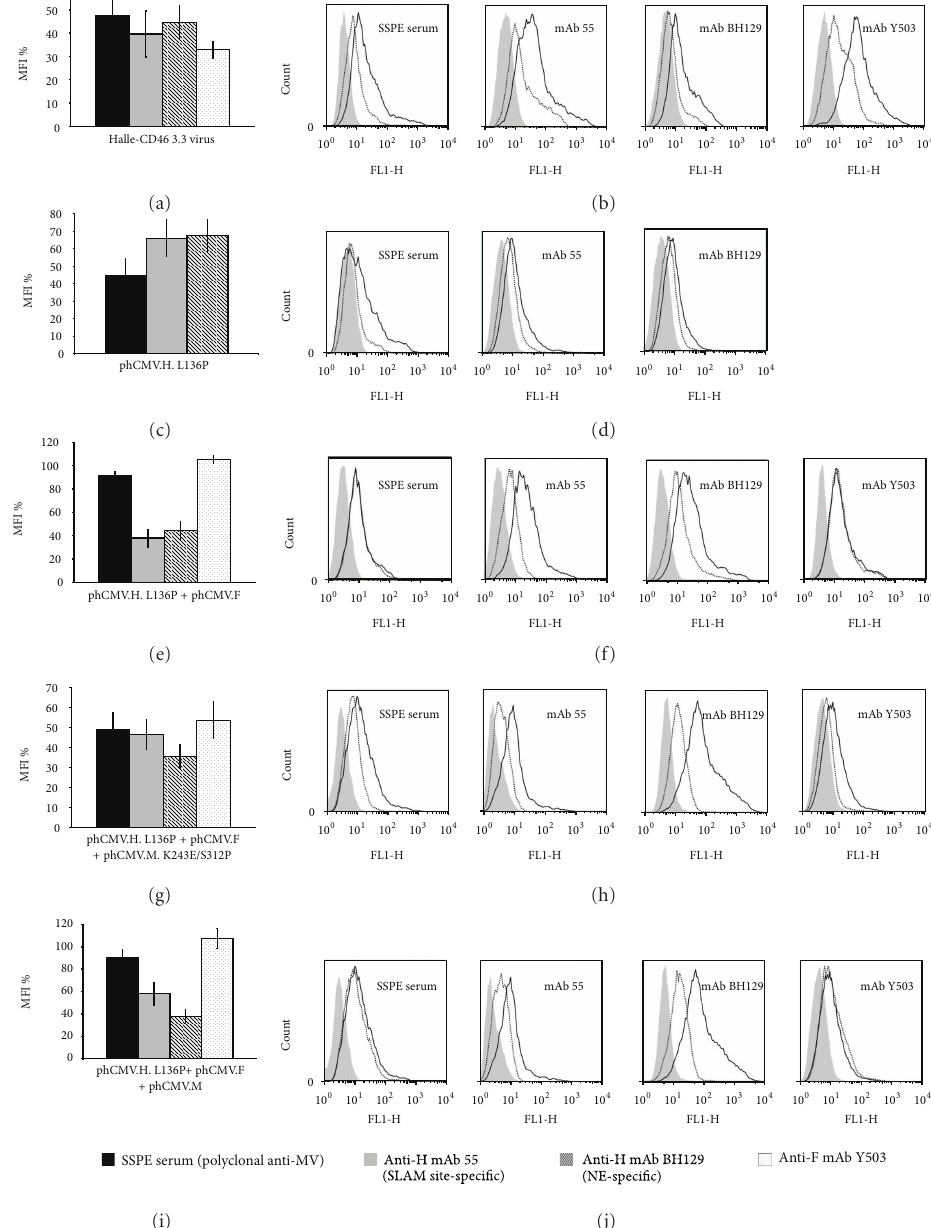
Figure 6: Flow cytometry analysis of escape mutant Halle-CD46 3.3 (H: L136P; F: no change; M: K243E, S312P). Vero-SLAM cells infected with the escape mutant virus or transfected with various phCMV plasmids in the presence, when necessary, of the antifusion tri-peptide FIP, were analysed 1 day after infection (or after transfection) using the indicated antibodies. Each overlay histogram represents one experiment; the MFI histogram data represent the mean percentages ± standard deviations for three experiments. These values were obtained by using nonmutated Halle virus or expressed nonmutated Halle proteins as controls. ((a) and (b)) Escape mutant Halle-CD46 3.3-infected cells; ((c) and (d)) cells transfected with phCMV.H.L136P; ((e) and (f)) cells cotransfected with phCMV.H.L136P + phCMV.F; ((g) and (h)) and ((i)